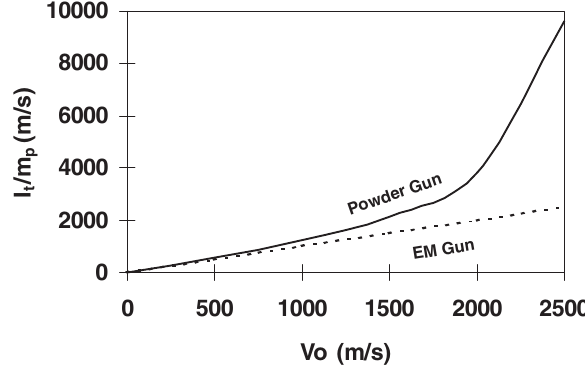
Fig. 3. Impulse ratio vs velocity.